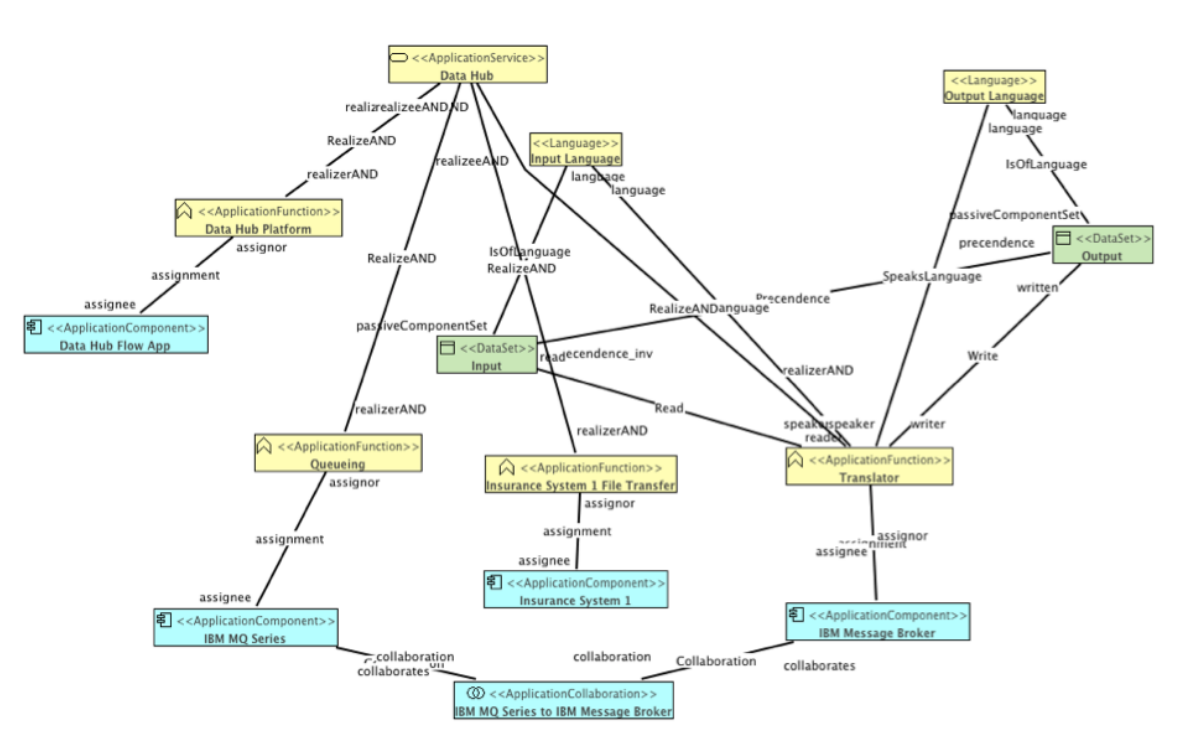
Figure 13. A view presenting the Data Hub application service at